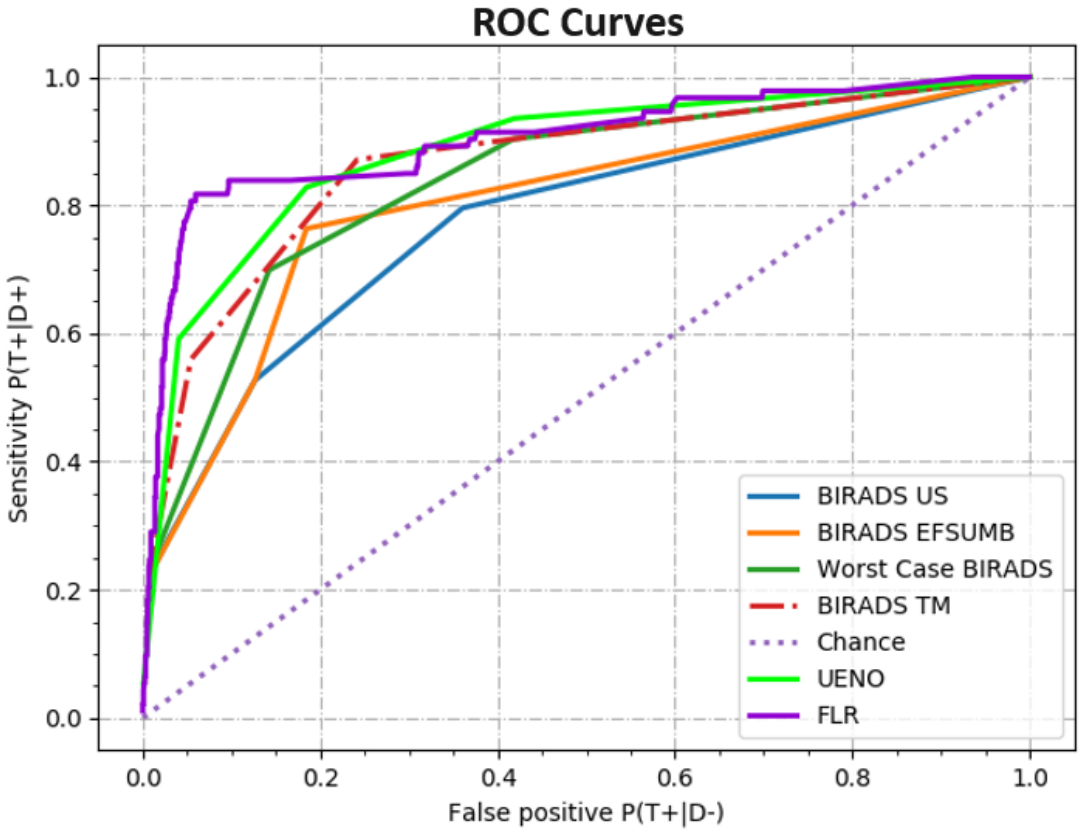
Figure 1. Receiver operating characteristic curves for proposed diagnostic methods.